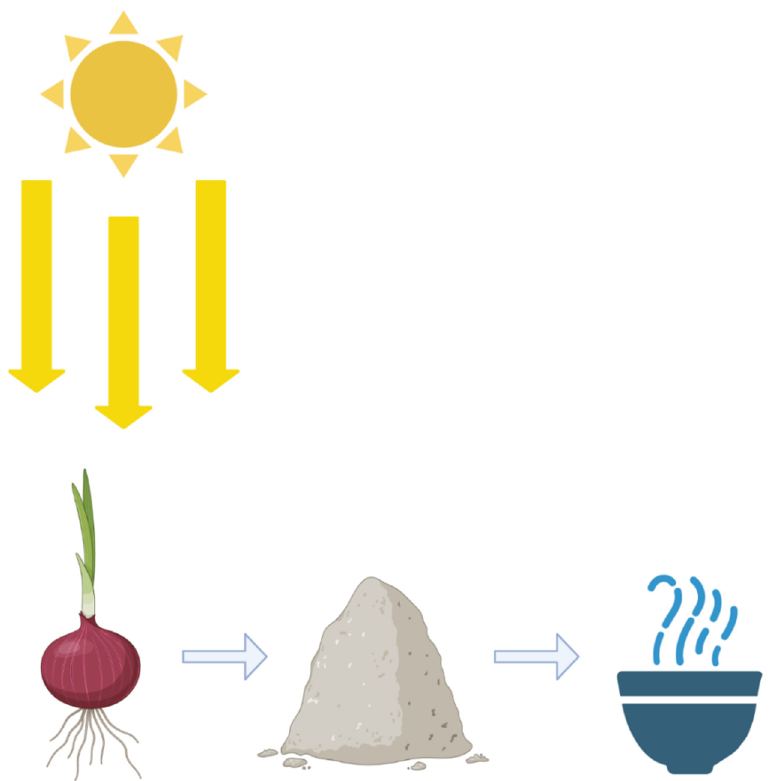
Figure 5. Creating nanoparticles from plant material. The creation of nanomaterials can be an incredibly complicated process, such as when FSP is employed. However, it can also be very straightforward. By drying onion peels, then grinding them up into a powder and introducing that powder to a solution with metal substrates with heat, nanoparticles can be created.